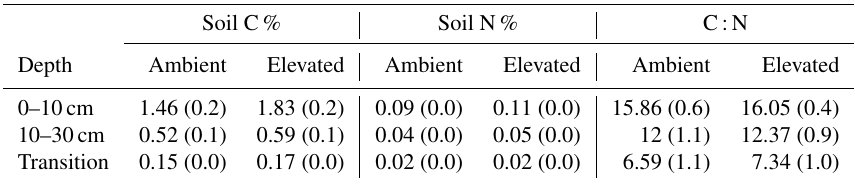
Table 2. Total soil C and N (%) and the C-to-N ratio for ambient a CO 2 and elevated e CO 2 in bulk soil at the three depths. The standard error is given in parenthesis. Results from statistical analysis are provided in Table